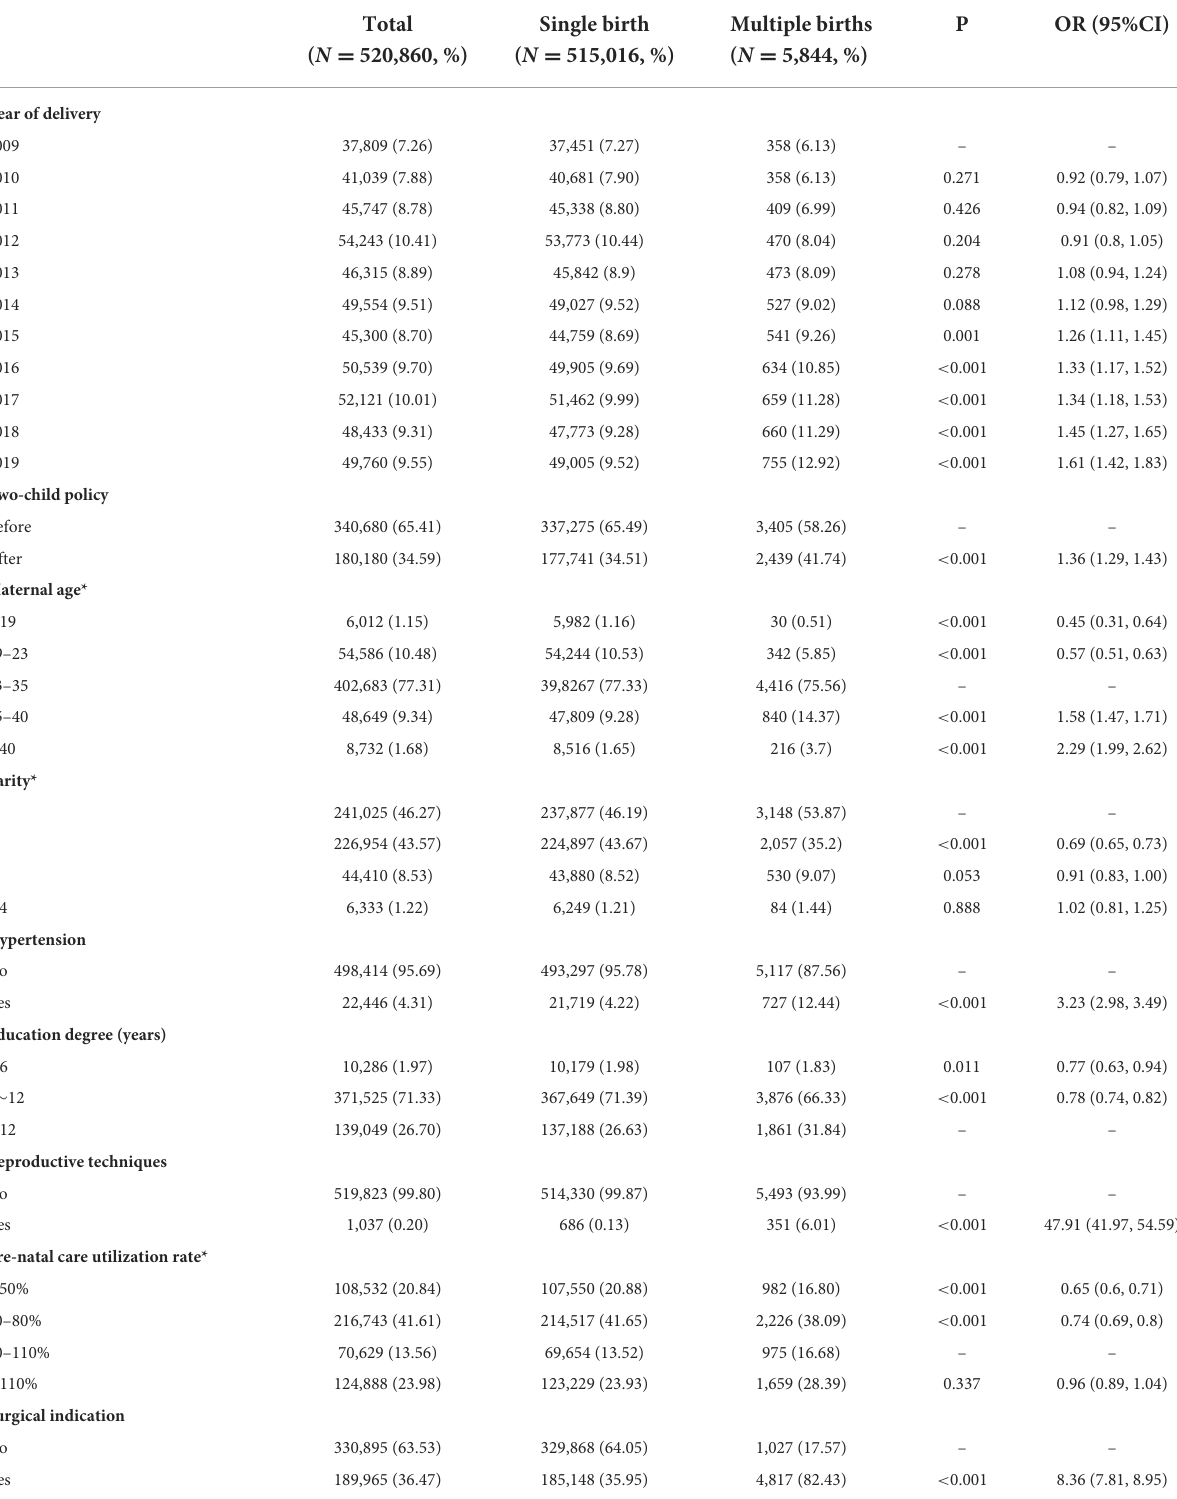
TABLE 1 Monofactor analysis for mothers with multiple and single births in Baoan Shenzhen,